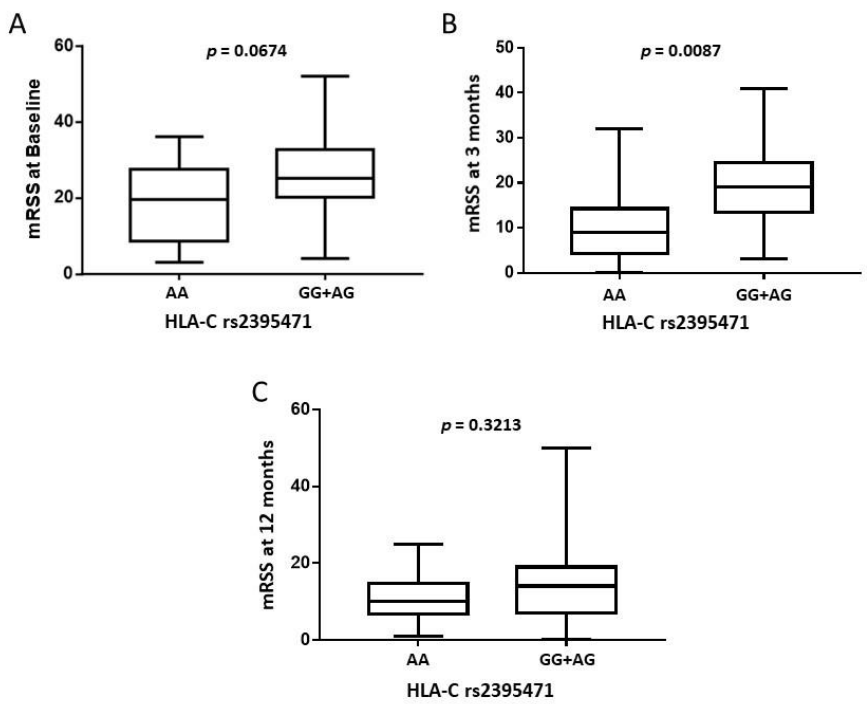
Figure 2. Comparison between the imputed HLA-C rs2395471 genotype and modified Rodnan Skin Scores (mRSS) in Systemic Sclerosis patients before autologous hematopoietic stem cell transplan- tation (baseline) ( A ), and at 3- ( B ) and 12-month ( C ) follow-up.